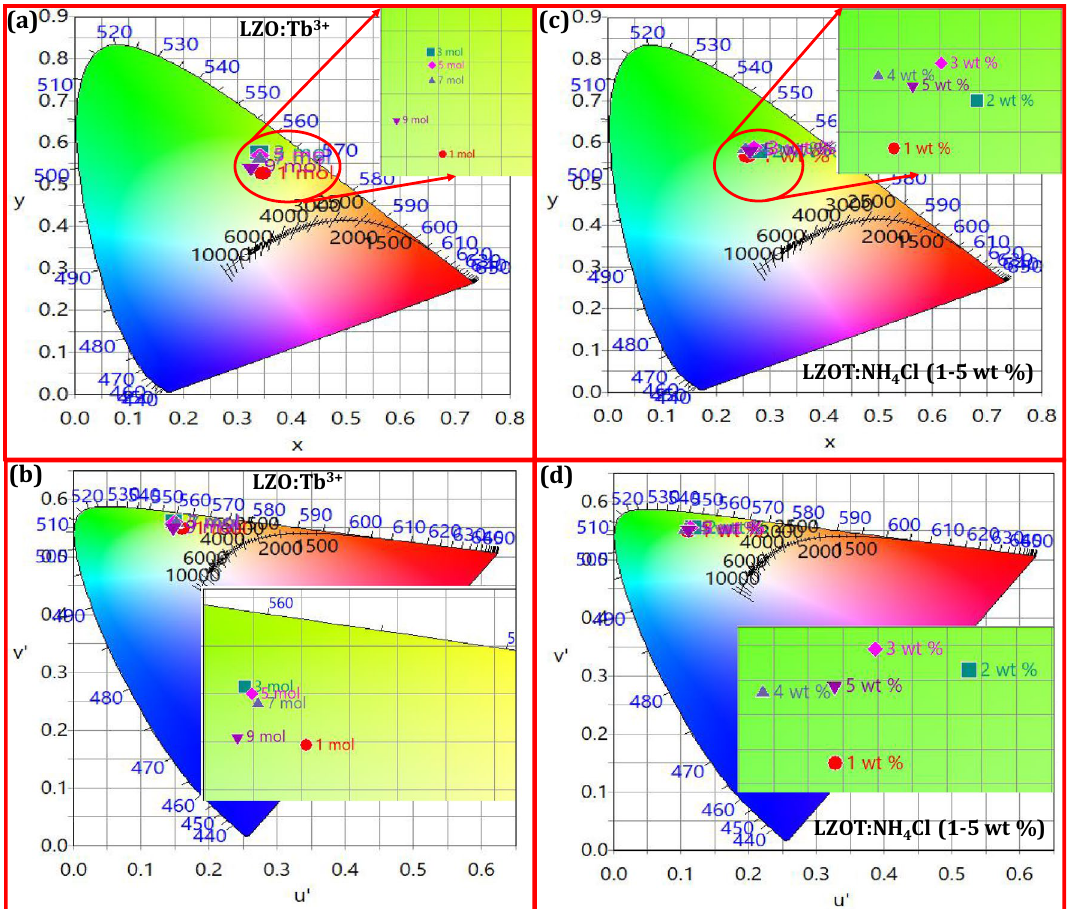
Figure 3. ( a and c ) CIE diagrams of the LZO:Tb 3+ (1–9 mol %) NPs and LZOT:NH 4 Cl (1–5 wt. %) NPs; ( b and d ) CCT diagrams of the corresponding samples of (a) and